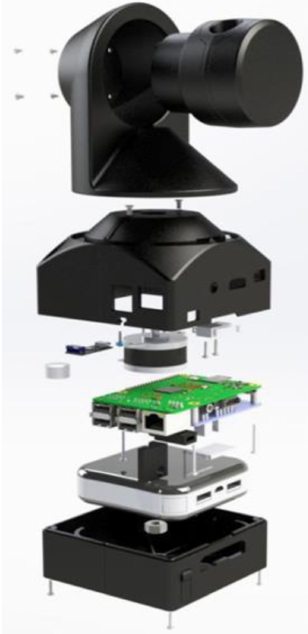
Figure A2. Exploded view of Scanse Sweep 3D LiDAR design